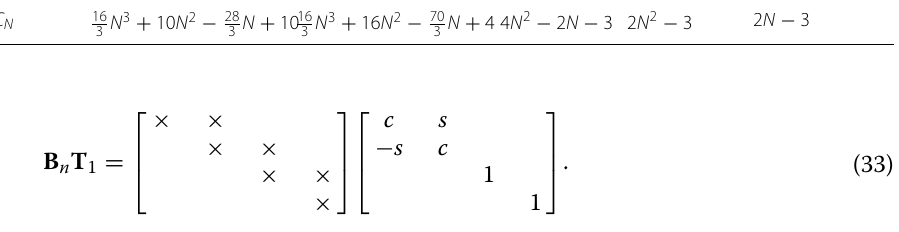
Table 5 Computational Cost of GRA Cost Item Sums Products